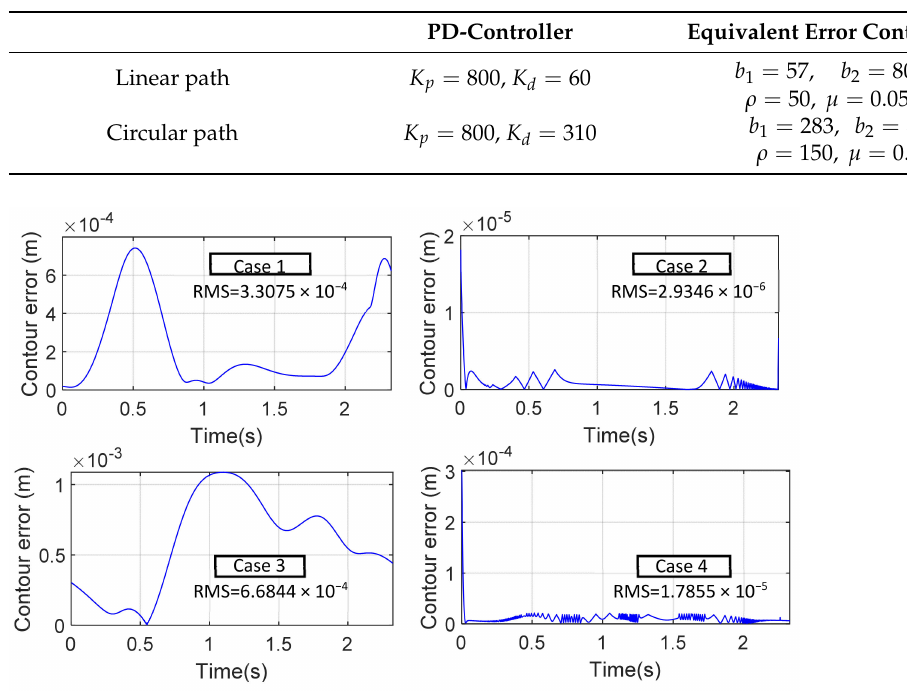
Figure 6. The position contour errors for the 4 simulation cases.